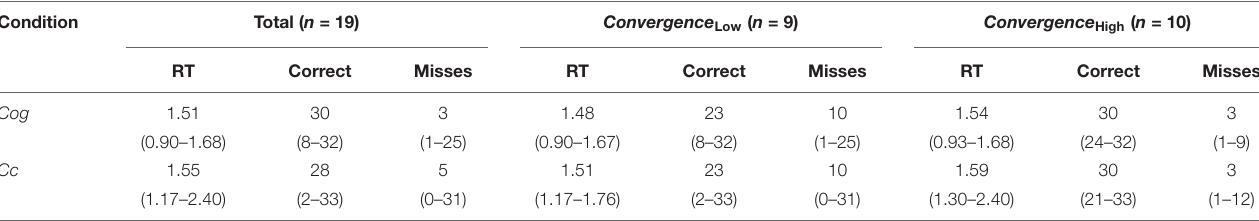
TABLE 1 | Median RT (min–max values), the correct number of responses (min–max) values and the number of misses (min–max) in the entire study population (Total), and in the Convergence Low ( n = 9) group and the Convergence High ( n = 10) group. Condition